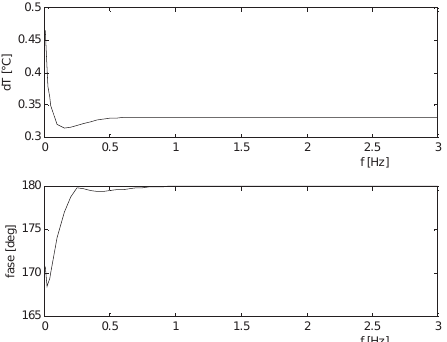
Fig. 8. Surface temperature variation and phase shift obtained from the